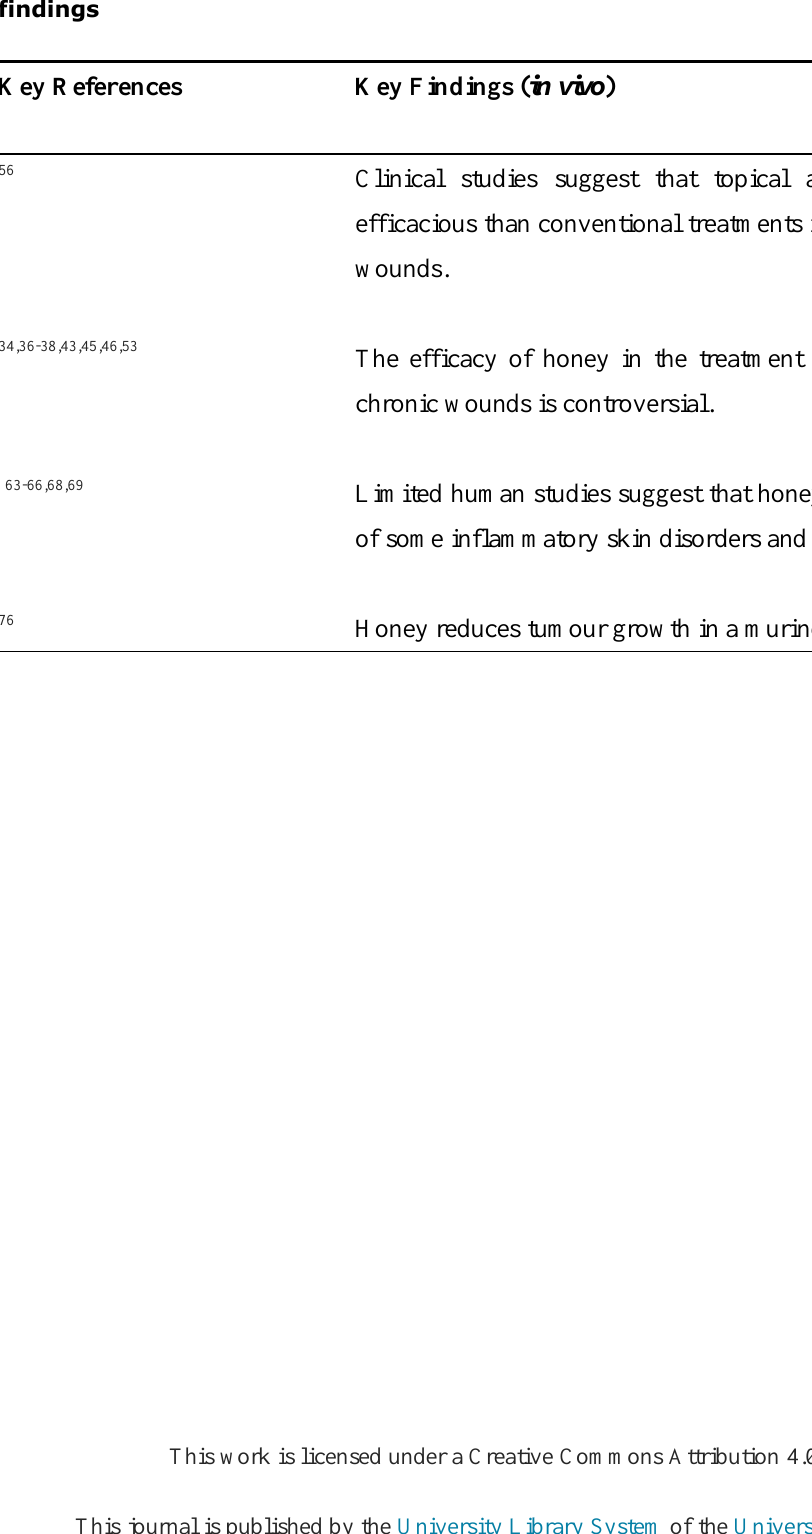
Table 2: Honey as a therapeutic agent for skin disorders; Summary of the key in vivo